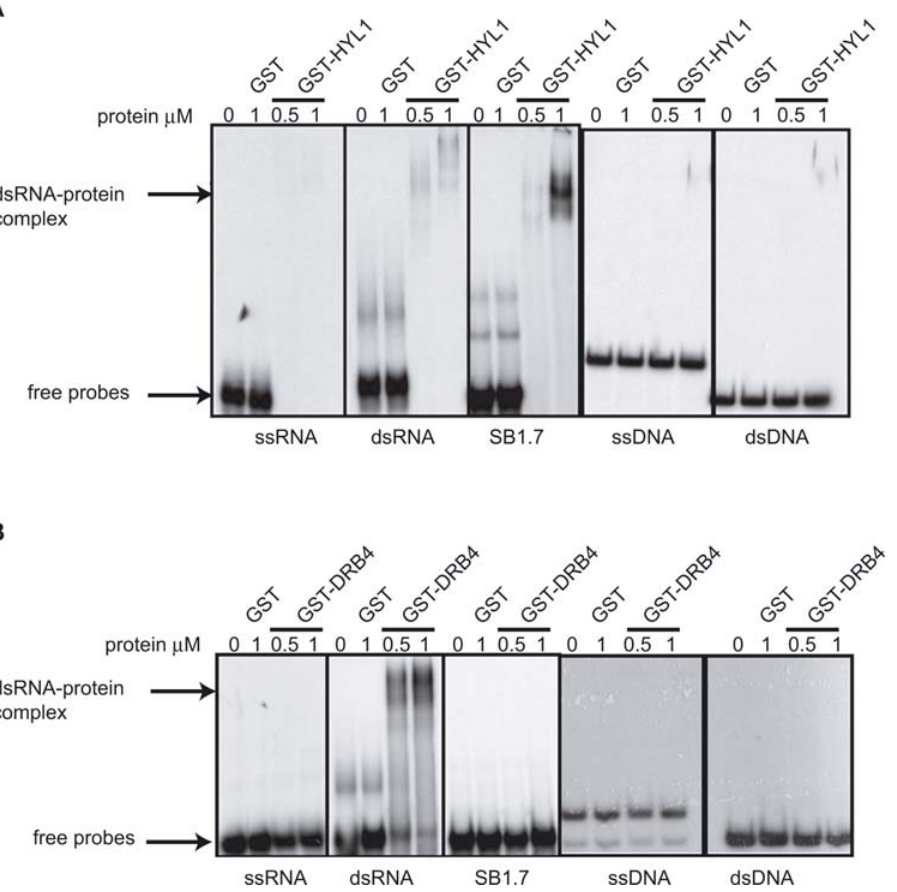
Figure 2. SINE RNA can bind to a subset of dsRBPs. A. Gel retardation experiments using GST, a recombinant GST-HYL1 fusion protein and [ a - 32 P]-labeled single-stranded RNA, perfect double-stranded RNA, SB1.7 RNA, single-stranded DNA and double-stranded DNA B. Gel retardation experiments using GST, a recombinant GST-DRB4 fusion protein and [ a - 32 P]-labeled single-stranded RNA, perfect double-stranded RNA, SB1.7 RNA, single-stranded DNA and double-stranded DNA. In both cases the amount of recombinant proteins used is indicated (in m M).